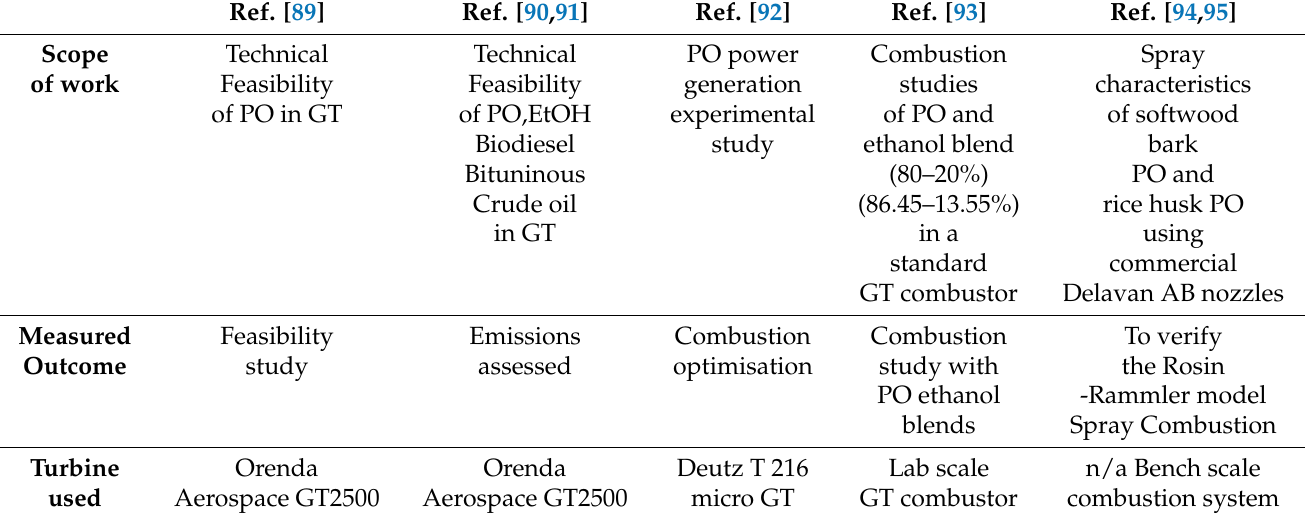
Table 3. Experimental work reported using biomass pyrolysis oil (PO) for gas turbine engine